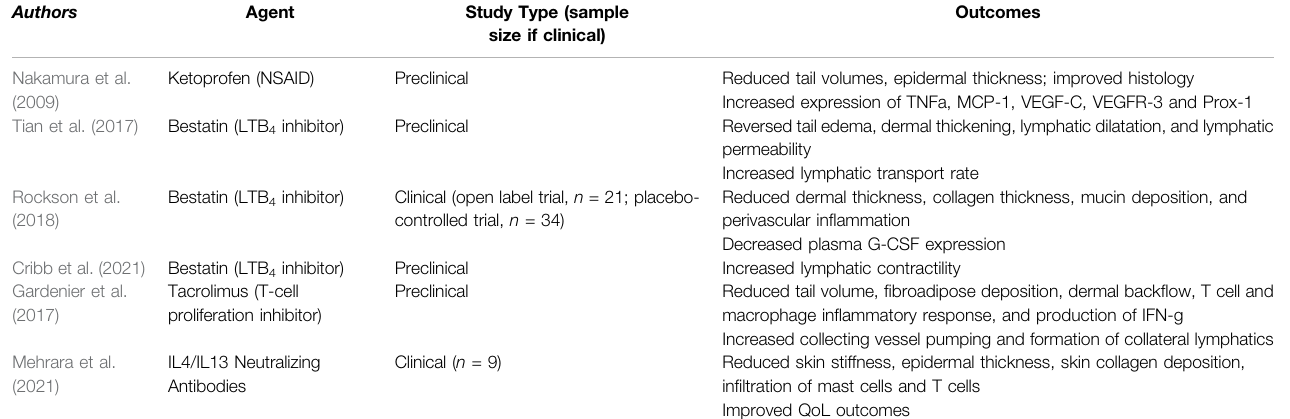
TABLE 2 | Anti-in fl ammatory Treatments for Lymphedema.